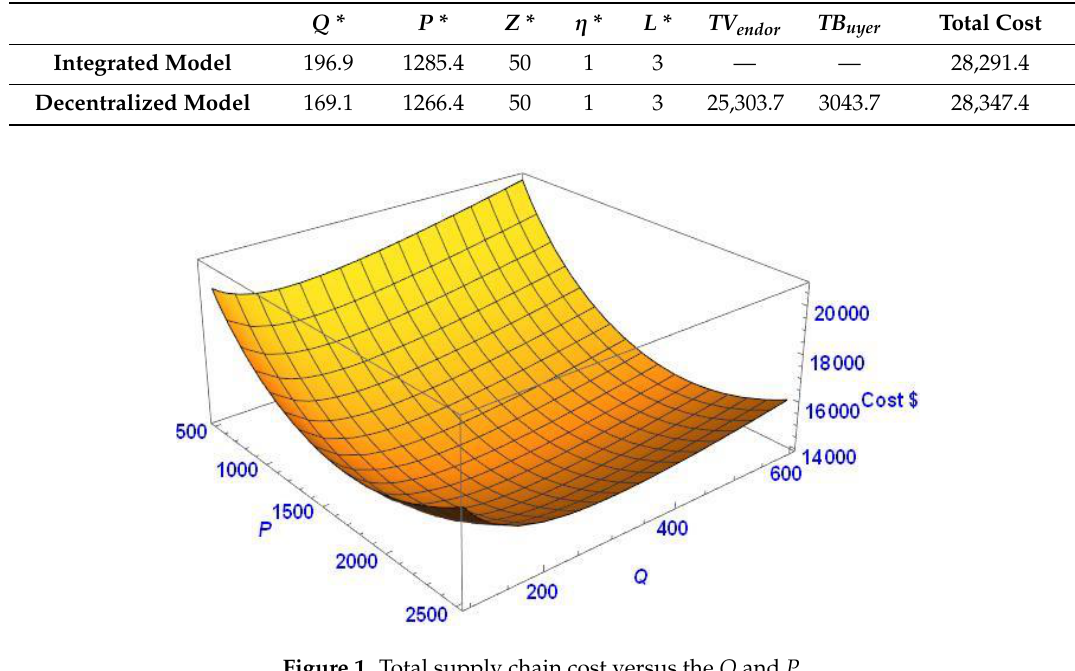
Figure 1. Total supply chain cost versus the Q and P .